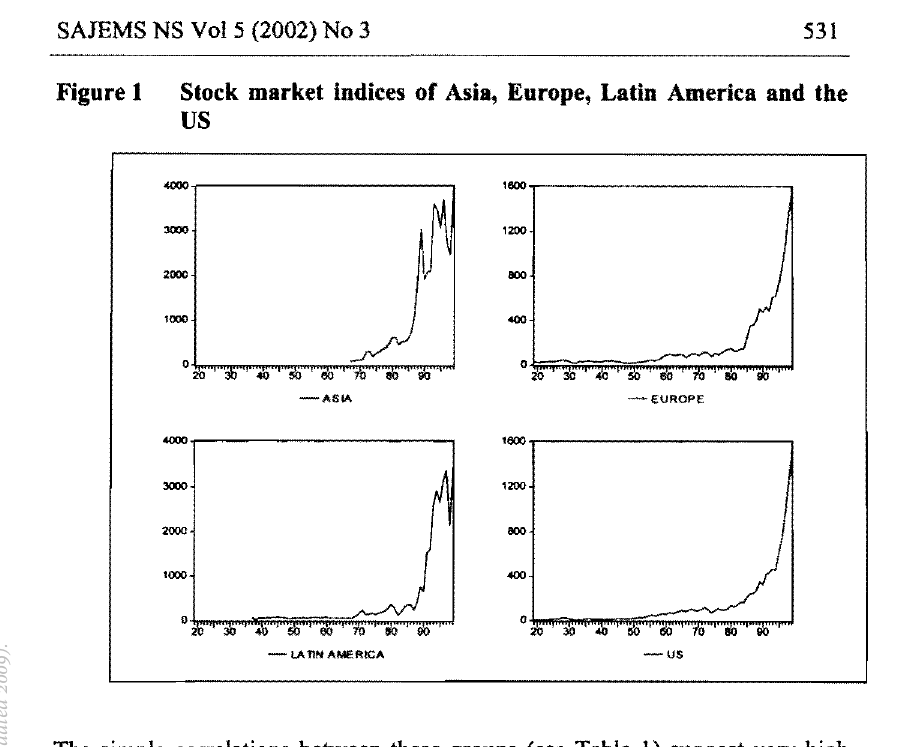
Stock market indices of Asia, Europe, Latin America and the